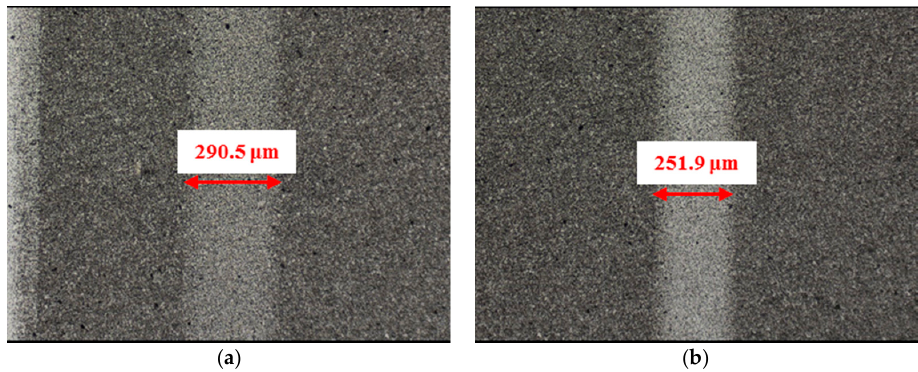
Figure 11. Wear performance of un-textured SiC under oil-lubricated conditions with a load of 75 N (×10): ( a ) untextured SiC–steel ball and ( b ) un-textured SiC–Si 3 N 4 ball.